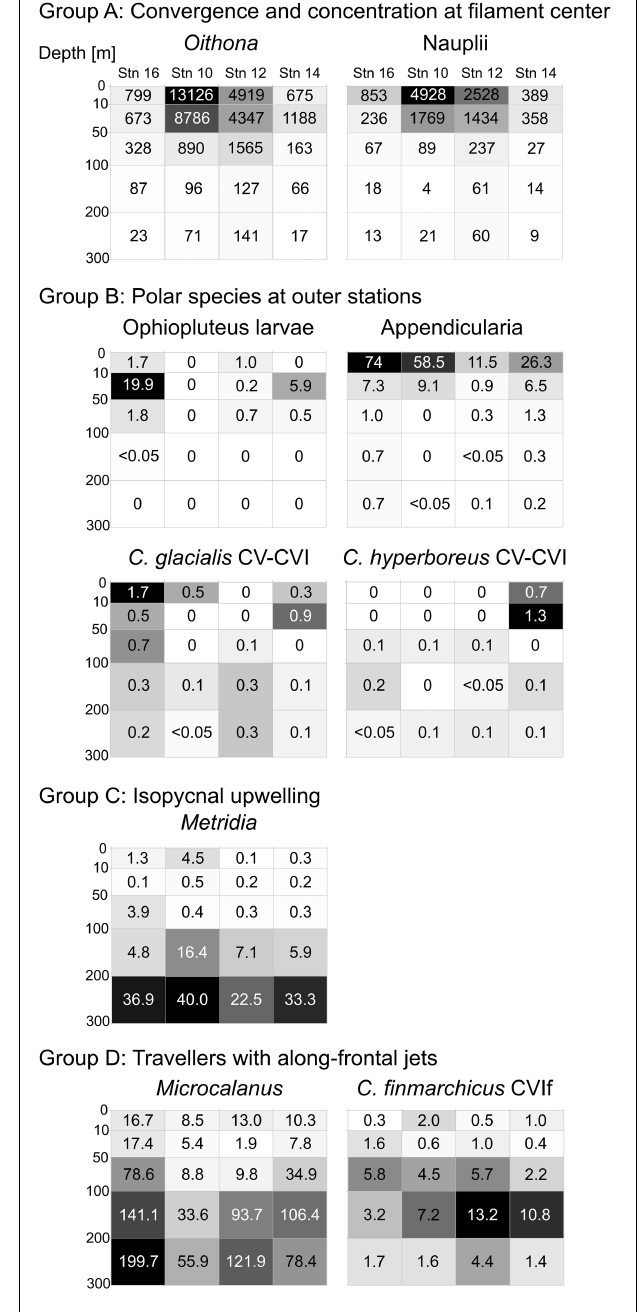
FIGURE 5 | Distribution heatmaps of most abundant and/or ecologically important zooplankton taxa sorted according to the four distribution types (Groups A–D) across the submesoscale filament. Numbers inside the heatmaps show abundances (ind. m − 3 ). Darker shading indicates higher abundances.